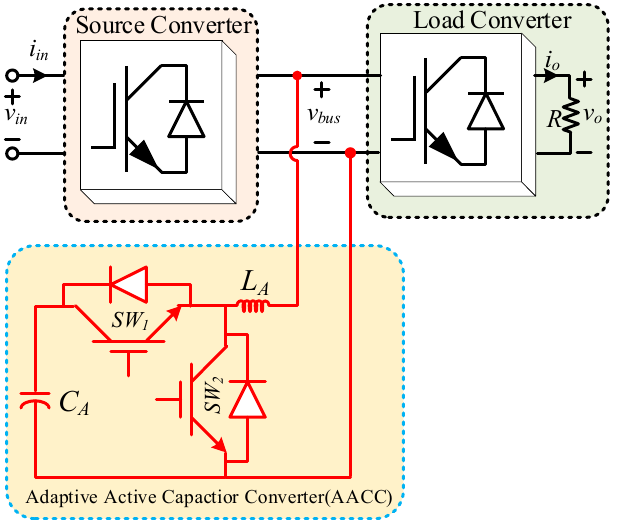
Figure 16. Intermediate-level active damping by adding an adaptive active capacitor converter (AACC) [103].